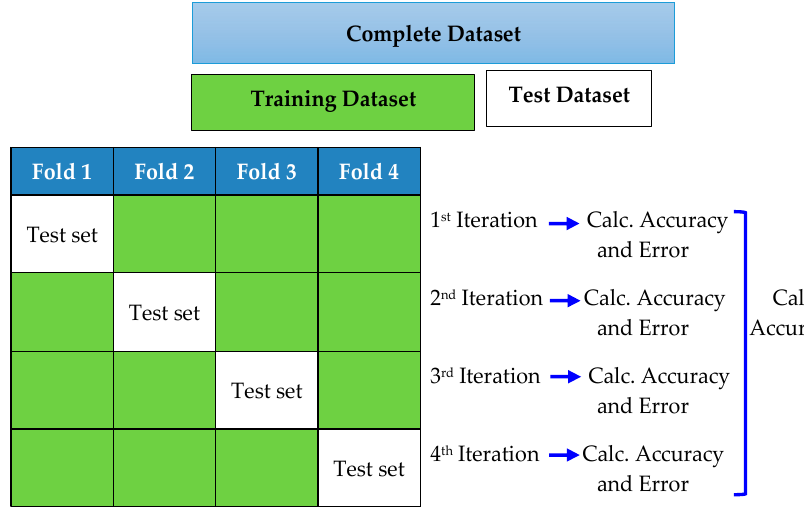
Figure 8. 4-Fold cross-validation scheme.